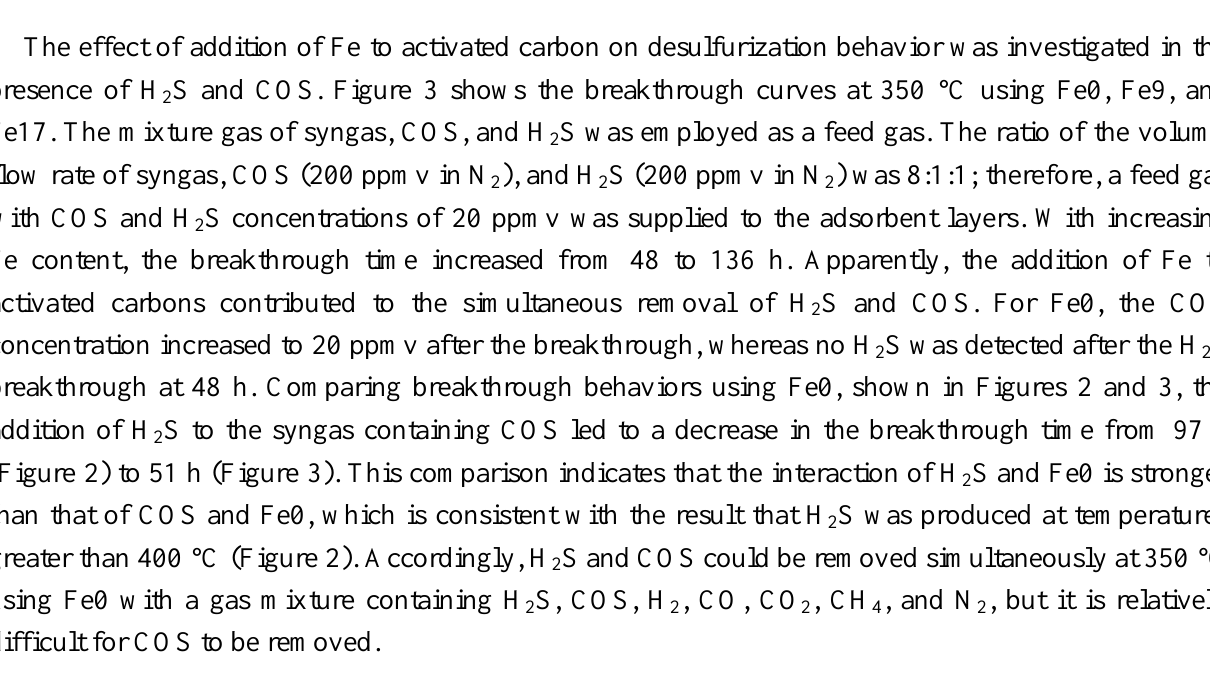
Figure 3. Breakthrough curves at 350 °C. (Feed gas; CO: 41.0 vol%, H : 28.1 vol%, 2 CH : 4.2 vol%, CO : 0.4 vol%, C H : 0.1 vol%, N : 26.3 vol%, H S: 20 ppmv, 4 2 2 4 2 2 COS: 20 ppmv), SV(350 °C) = 1592 h −1 . The two Fe-supported activated carbon samples with Fe contents of 9 wt% and 17 wt% are denoted by Fe9 and